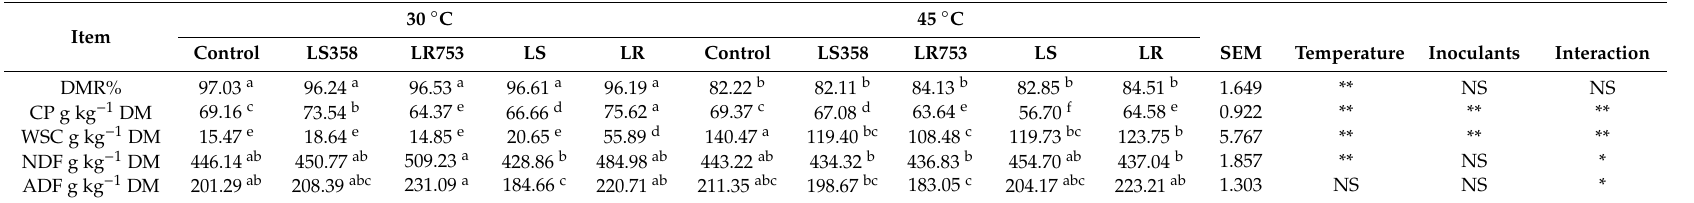
Table 2. Chemical composition of corn silage ensiled for 60 d at 30 and 45 ◦